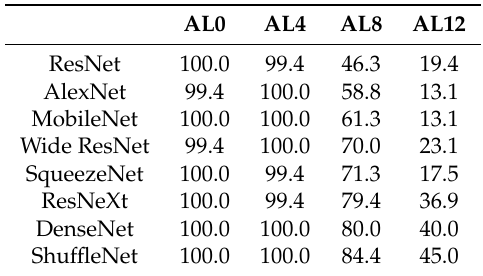
Table 8. Underwater AL0-4 inter-set test. Architectures trained on ALO-4 and tested against all AL data